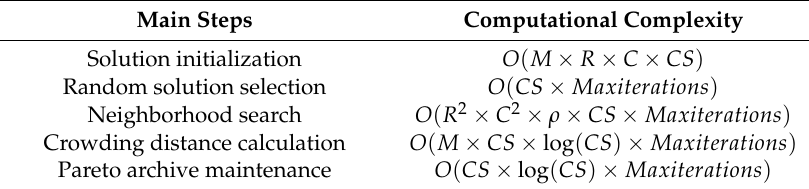
Table 2. Computational complexity of